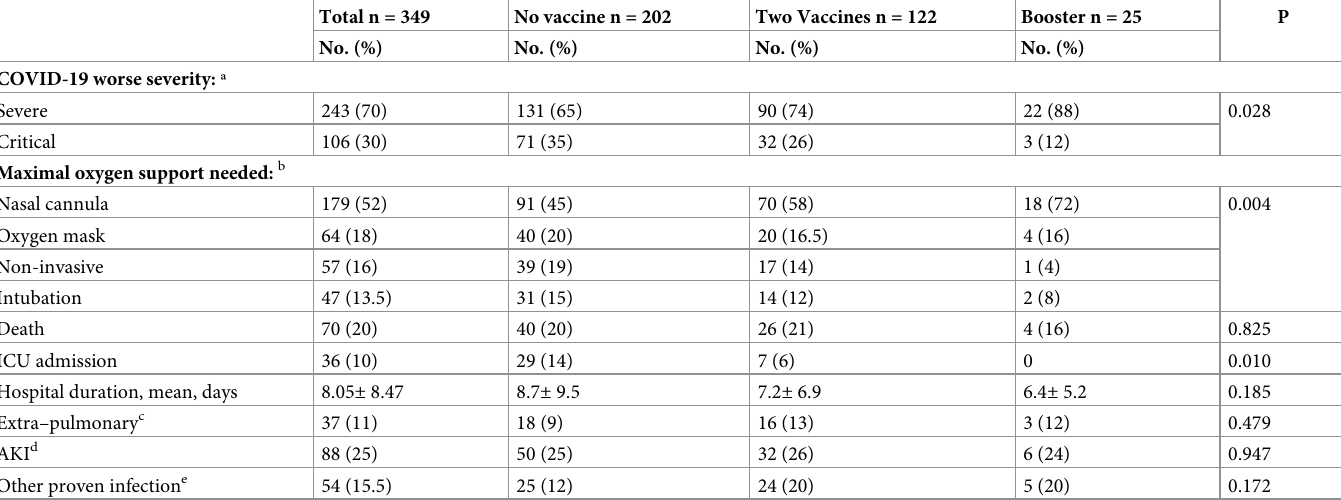
Table 2. Outcomes of hospitalized severe or critical COVID-19 patients by vaccine